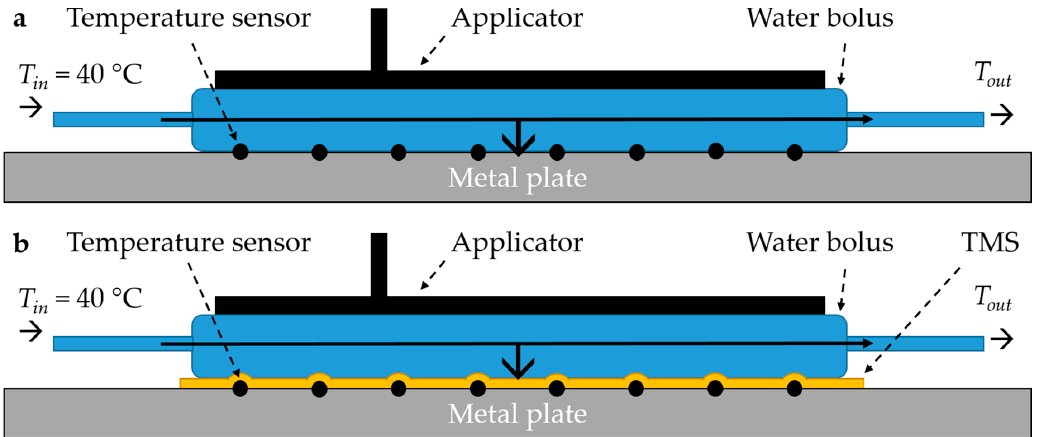
Figure 6. Experimental set-up to determine the heat transfer of ( a ) the water bolus alone, and ( b ) the water bolus with the thermal monitoring sheet (TMS). water bolus with the thermal monitoring sheet